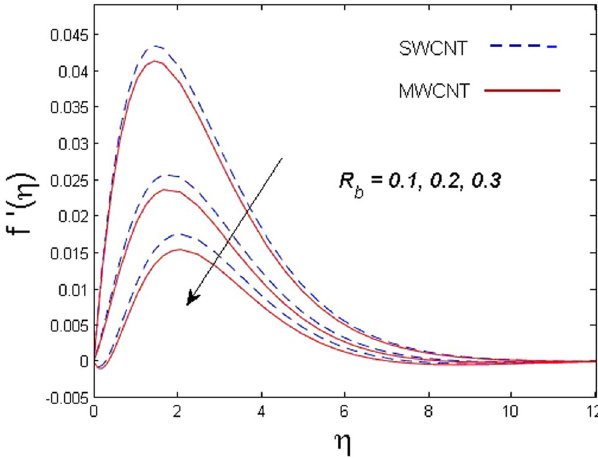
Figure 7. Outcome of R b on f ( ) η ′ .